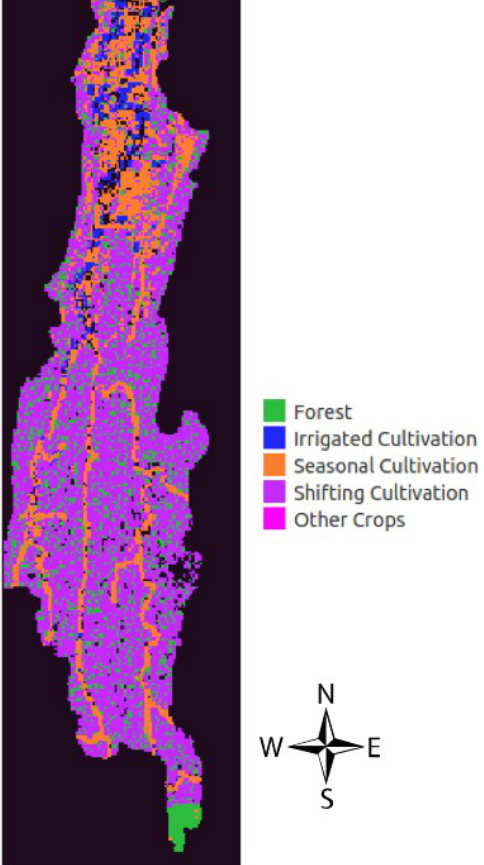
Figure 9. Land use map for 2035 when simulated with doubled population scenario for the year